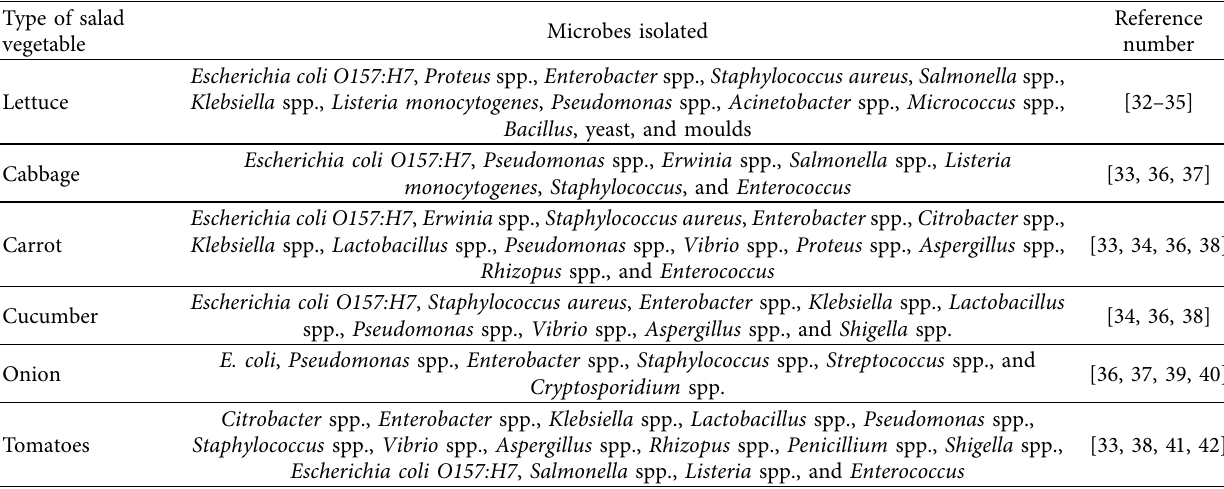
Table 1: Microbes isolated from notable